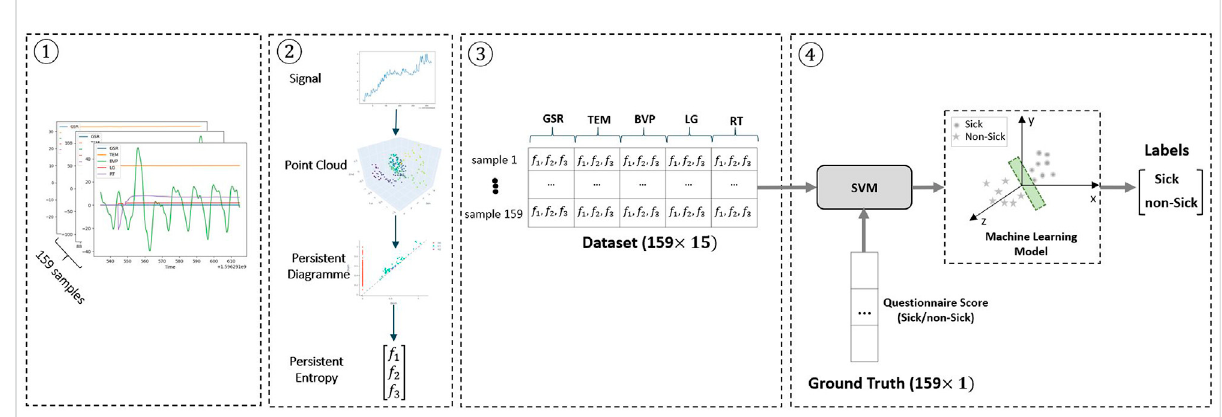
FIGURE 6 Block diagram of the cybersickness prediction method. 1) Normalization of the time series as a pre-processing step 2) Applying TDA and vectorizing persistent diagram to persistent entropy 3) Making the dataset (159 × 15 matrix) from the features descriptors that characterize the sample ’ s data 4) Feeding the dataset into the SVM classi fi er along with ground truth labels (i.e., sick:1 and non-sick:0) provided by the questionnaire scores. Finally, SVM fi nds a suitable hyperplane (the green surface shown in the Figure) that can cleanly separate the samples into two groups (i.e., sick and non-sick). The method ’ s output is a set of predicted labels based on the decision made by the SVM classi fi